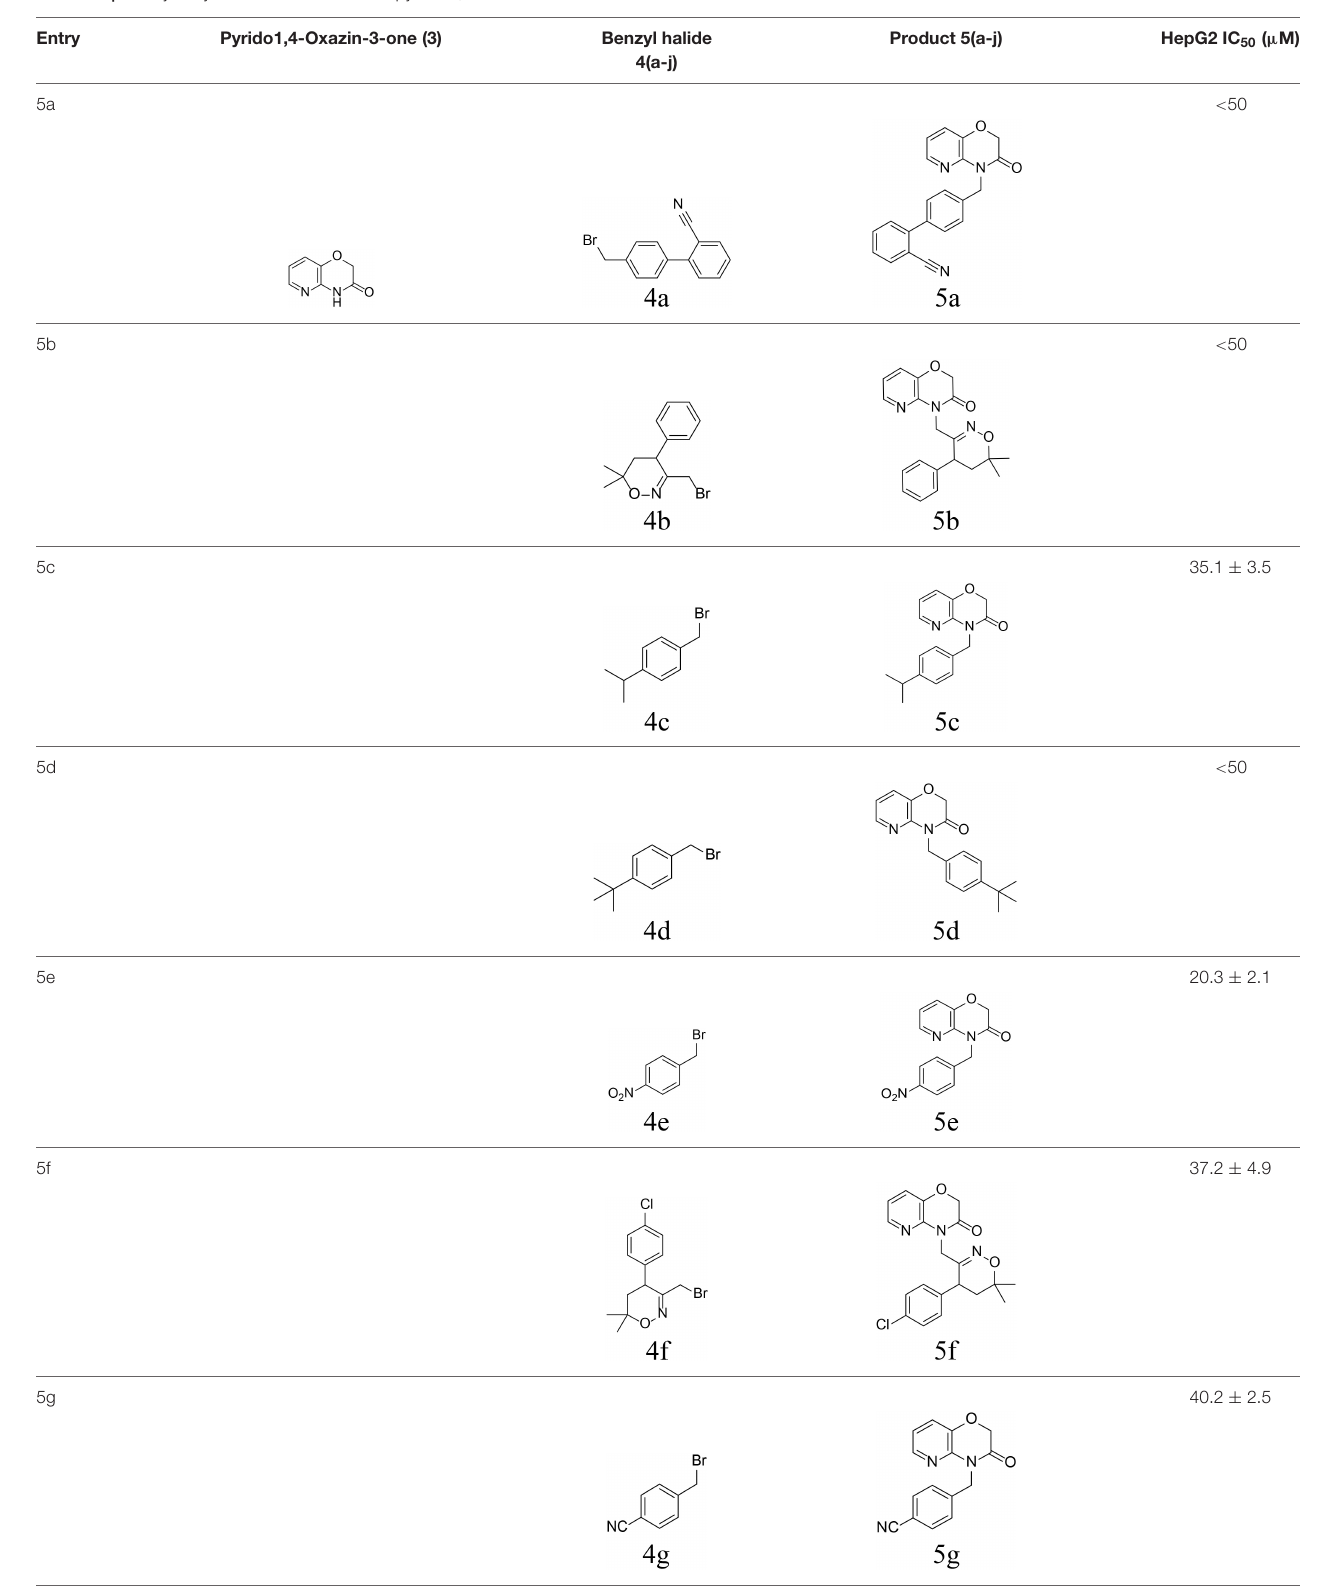
TABLE 1 | Library of synthesized N-substituted